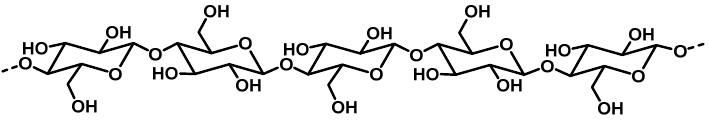
Figure 1. Structure of cellulose biopolymer.